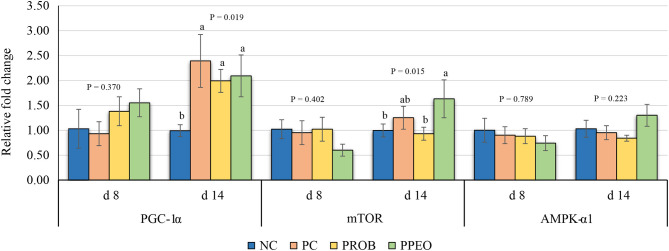
Relative mRNA abundance of peroxisome proliferator-activated receptor-gamma coactivator (PGC)-1α, mechanistic target of rapamycin (mTOR) and AMP activated protein kinase (AMPK)-α1 in the jejunum of broiler chickens on day (d) 8 and 14. Birds reared under a naturally occurring necrotic enteritis challenge model. Treatments include: NC (negative control): corn-soybean meal basal diet; PC (positive control): NC + 20 g virginiamycin (453 g Stafac®20)/ton diet; PROB (Probiotic): NC + B. licheniformis spores at the level of 227 g/ton diet; PPEO (probiotic/prebiotic/essential oil supplement): NC + 453 g/ton of a supplement containing B. licheniformis spores, mannan-oligosaccharides, β-glucans (1,3 and 1,6), capsaicin, and curcuma. Values are represented as a n-fold difference relative to the calibrator (NC). Results are given as means (n = 8) for each treatment. Error bars indicate standard errors. For each gene and sampling day, columns with different letters are significantly different (P < 0.05).